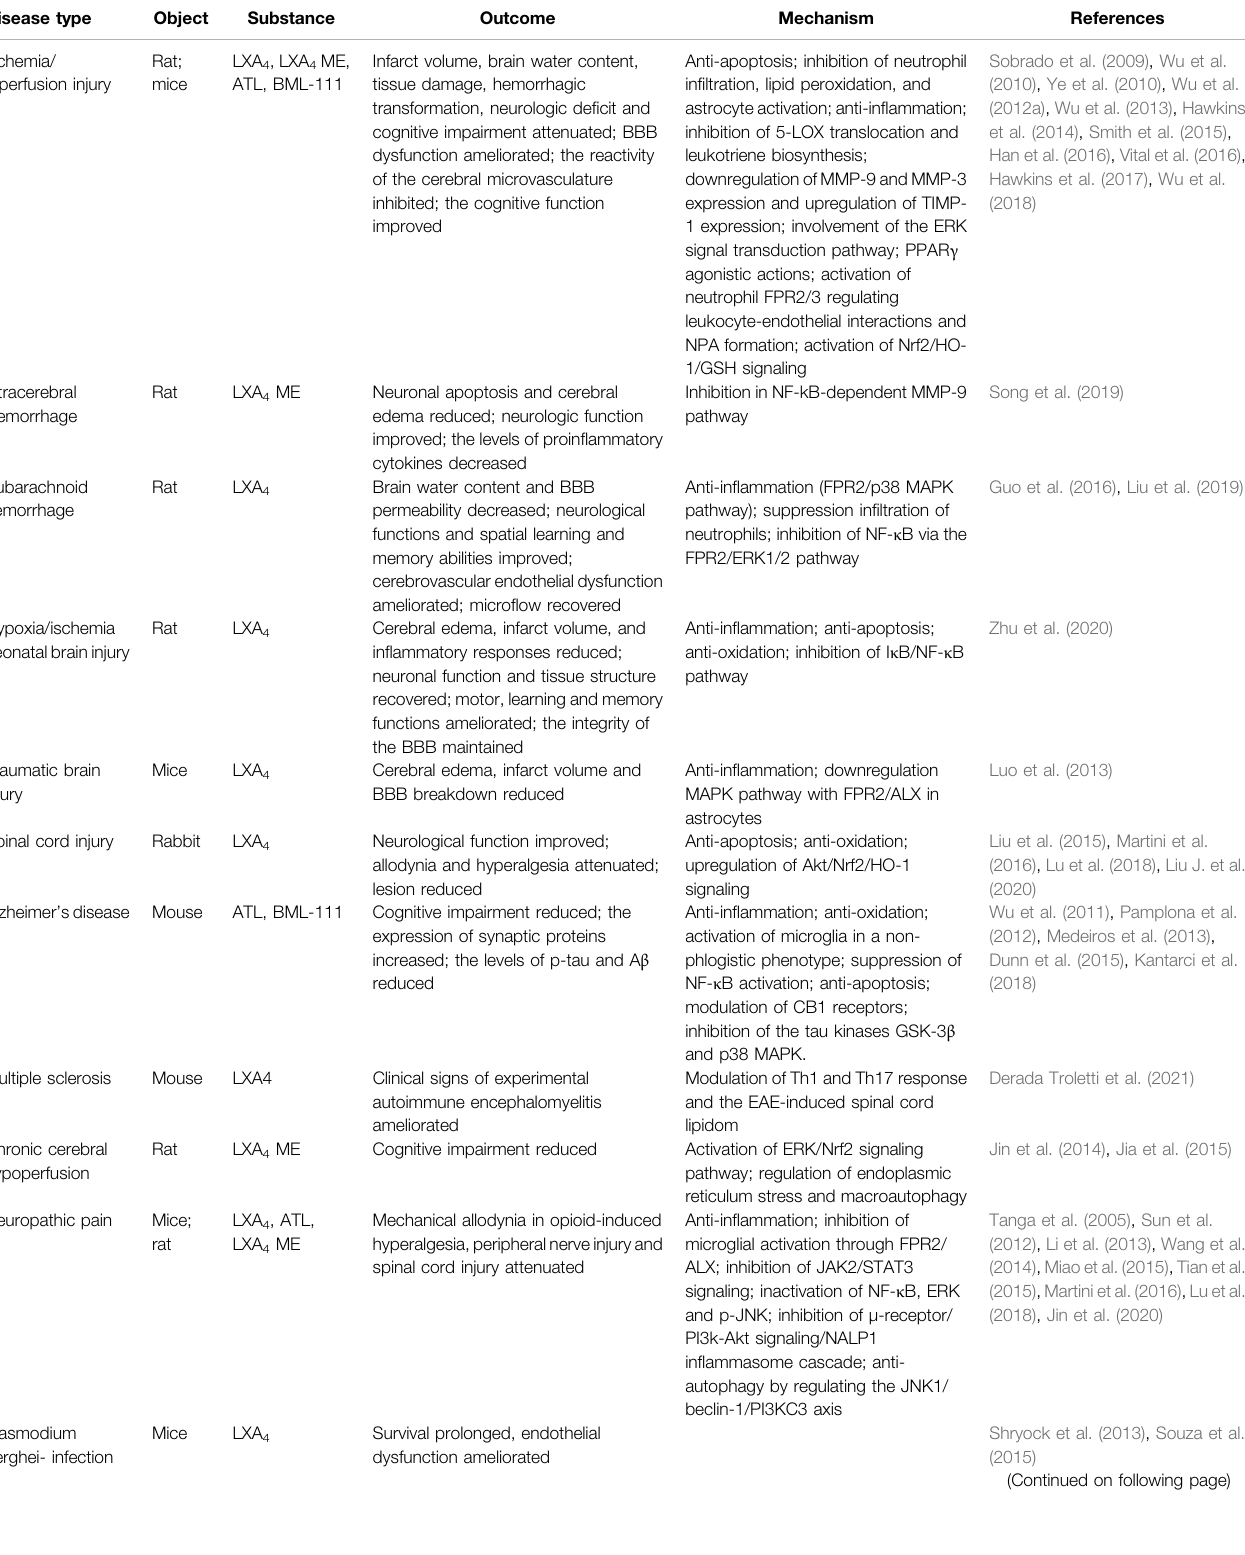
TABLE 2 | Summary of in vivo studies on the neuroprotective effects of